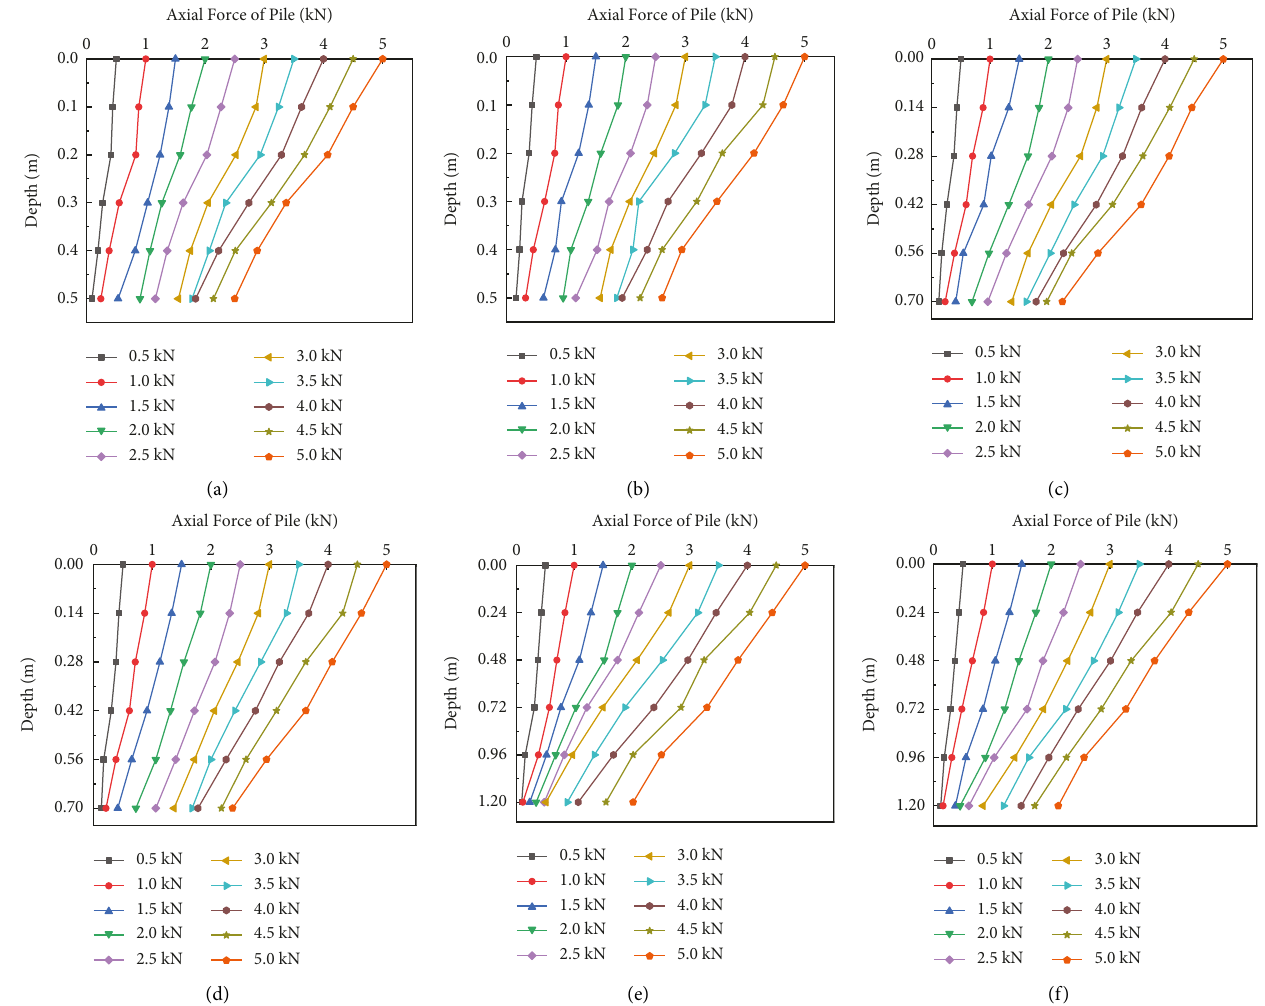
Figure 16: Axial force curves of simulation piles. (a) S0. (b) S1. (c) S2. (d) S3. (e) S4. (f) S5.